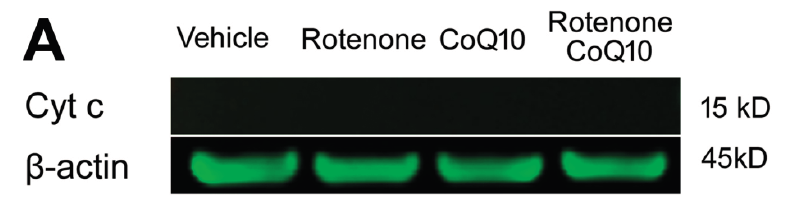
Figure 6. Cytochrome c and cleaved caspase-9 levels in the cytosolic and mitochondrial fractions. Equal amounts of protein (20 µg) were loaded into each well. ( A ) cytochrome c could be hardly traced in the cytosolic fraction; ( B ) Cytochrome c level in the mitochondrial fraction. VDAC served as an internal protein loading control for mitochondrial fraction; ( C ) A bar graph showing semiquantitative band intensity ratio between cytochrome c and VDAC. Groups with same letter labeled on the top of each column indicate no significant difference ( p > 0.05) in the mitochondrial fraction; ( D ) Cleaved caspase-9 in the cytosolic fraction. β -actin served as an internal protein loading control; ( E ) A bar graph showing semiquantitative band intensity ratio between cleaved caspase-9 and β -actin. Groups with same letter labeled on the top of each column indicate no significant difference ( p >